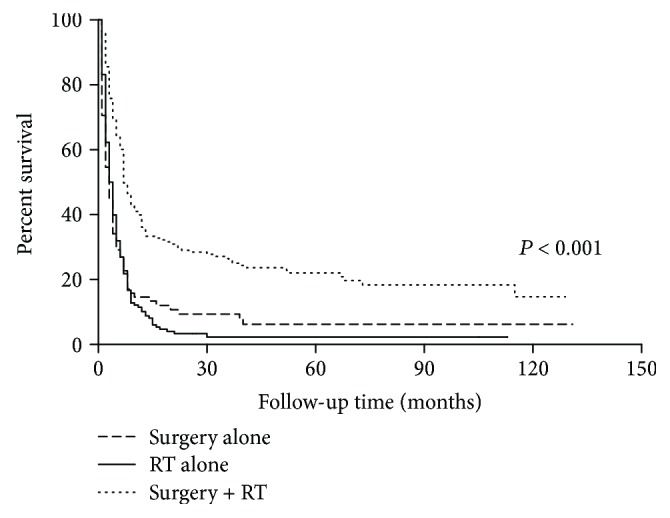
Surgery + RT could significantly improve overall survival in anaplastic thyroid cancer patients compared with surgery alone and RT alone.